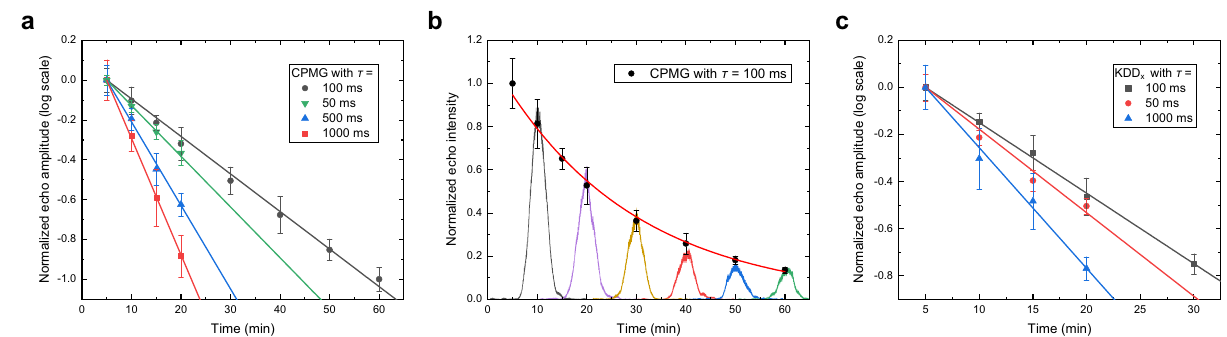
Fig. 3 Measurements of the memory lifetime. a , c Decay of the spin-wave AFC echo with the CPMG and KDD x sequences, respectively. The two DD sequences reach their longest storage lifetime of 52.9 ± 1.2 and 33.3 ± 1.1 min with a period τ = 100 ms. b The decay of the echo intensity using CPMG with τ = 100 ms versus the storage time. Some of the single-shot oscilloscope traces of the read out signals are included. Each data point is averaged four times. The error bars indicate one standard deviation of the echo area.